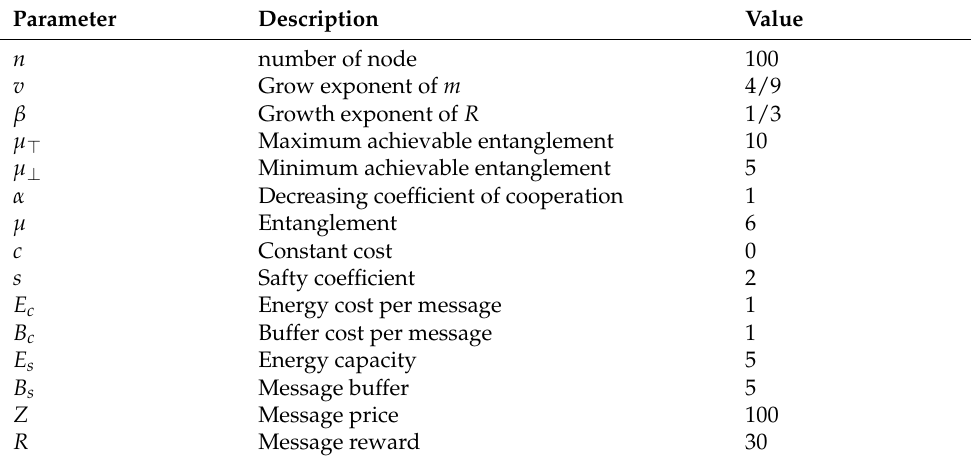
Table 3. Value of